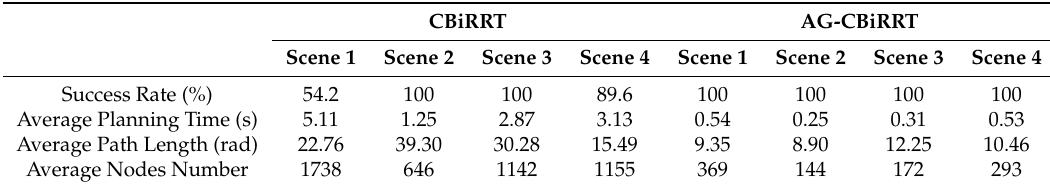
Figure 4. The moving trajectory of the manipulator in four scenes. The end effector is required to always keep the cup upright during the movement. To clearly display the environment model, the robot states on the path are not all displayed. Table 1. Single manipulator motion planning under task constraints.